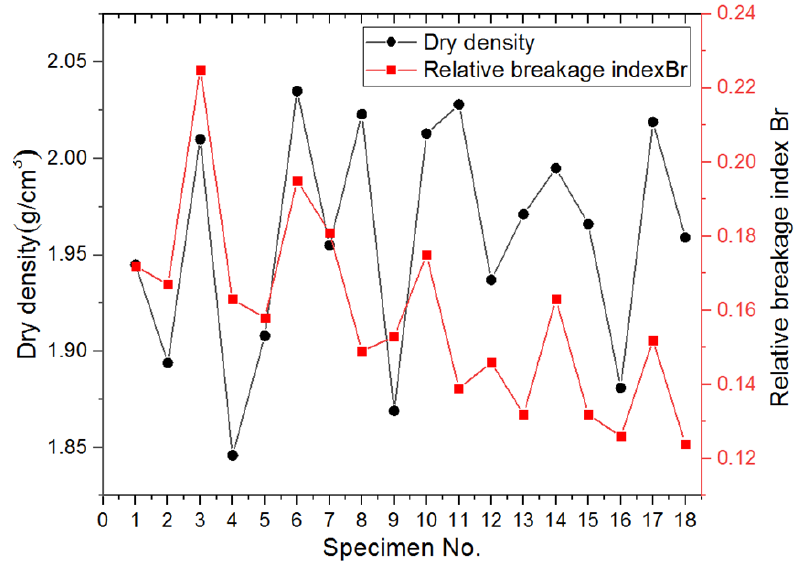
Figure 23. The relative breakage index Br versus final achieved dry density for 18 gyratory specimens included in the orthogonal array testing matrix.